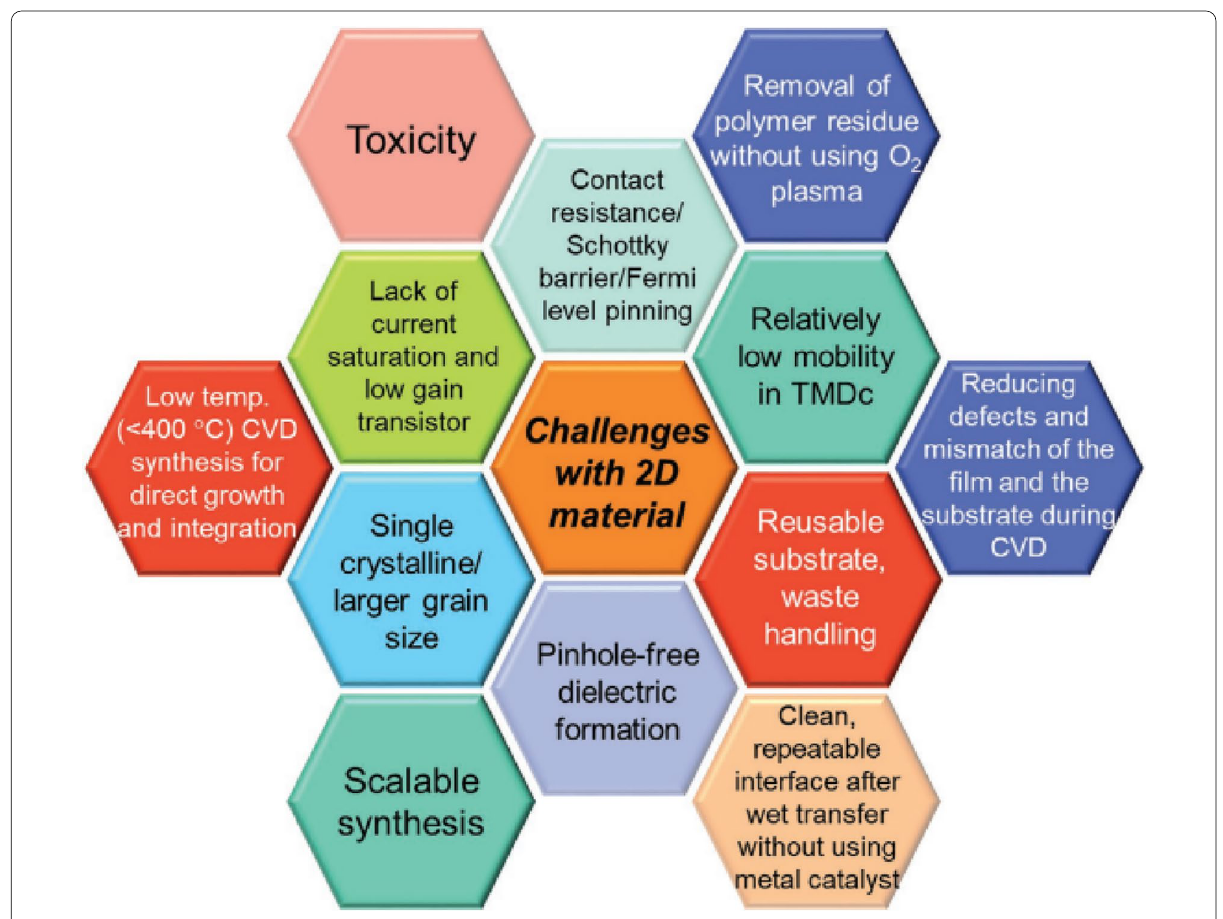
Fig. 14 Challenges faced by 2D materials from synthesis to device applications